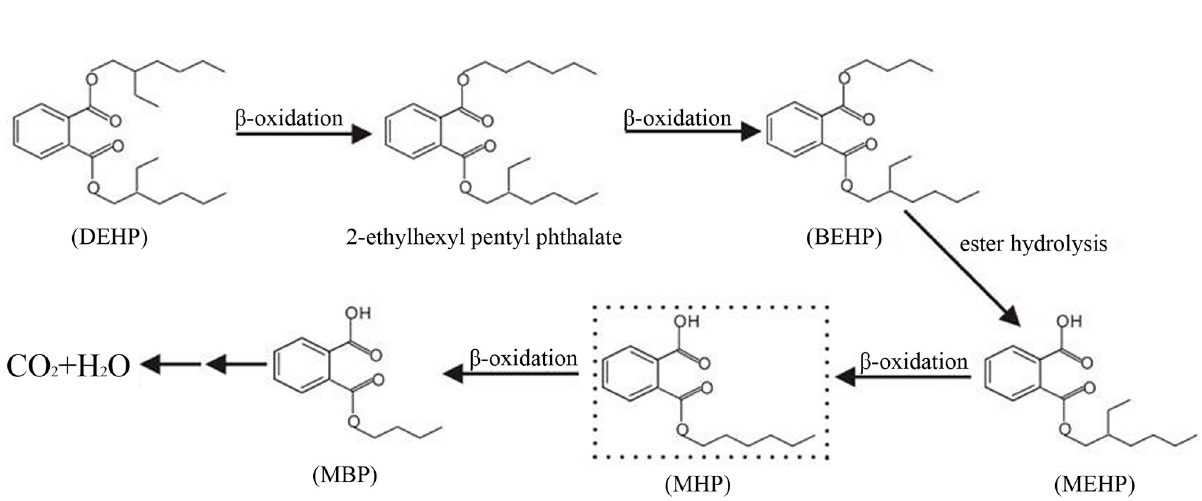
Fig 7. Proposed biochemical degradation pathway for DEHP by LF. The dashed box indicates the inferred intermediate not detected in this study.